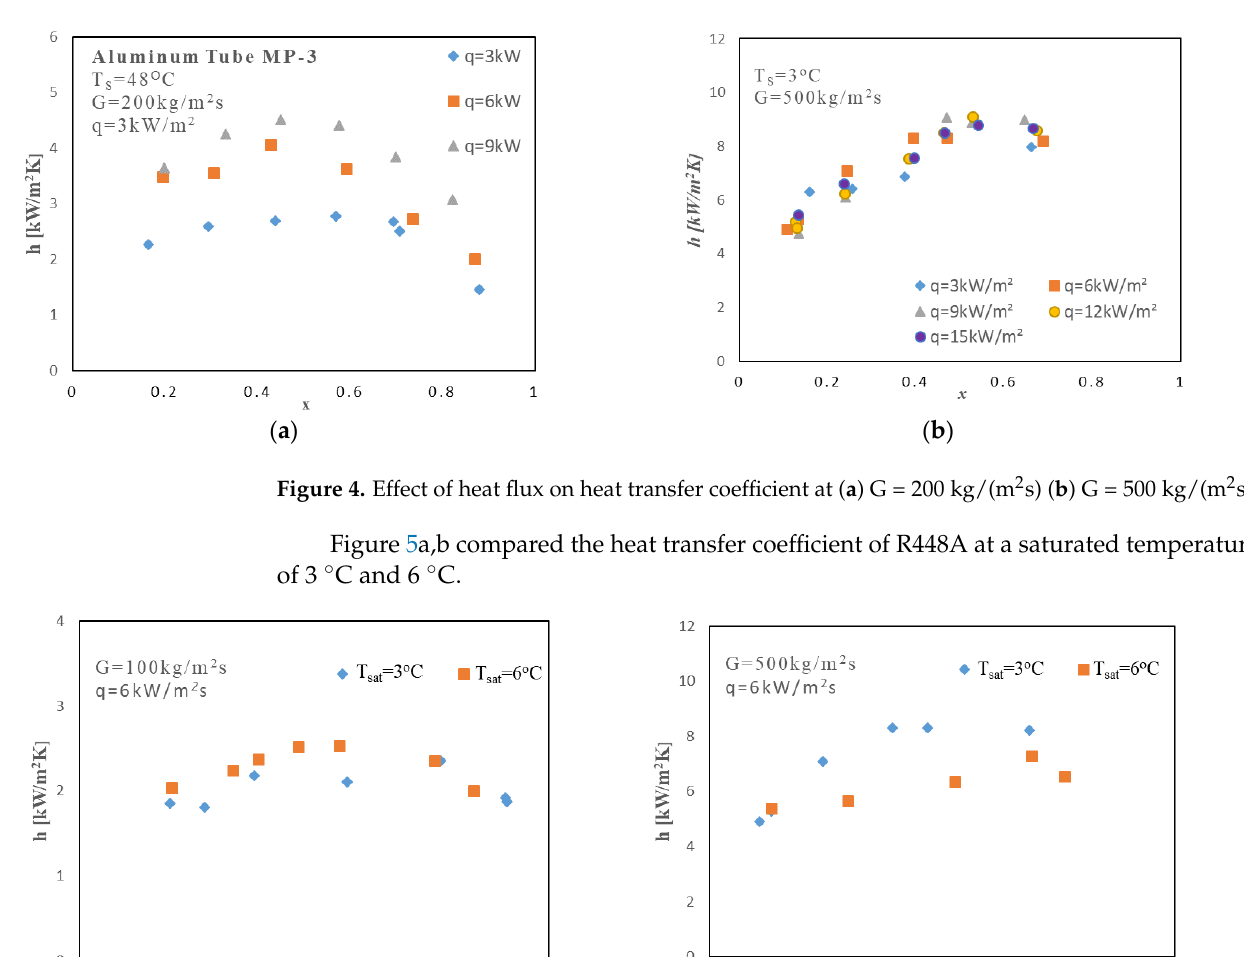
Figure 5. Effect of saturated temperature on heat transfer coefficient at ( a ) low mass flux condition ( b ) high mass flux condition.